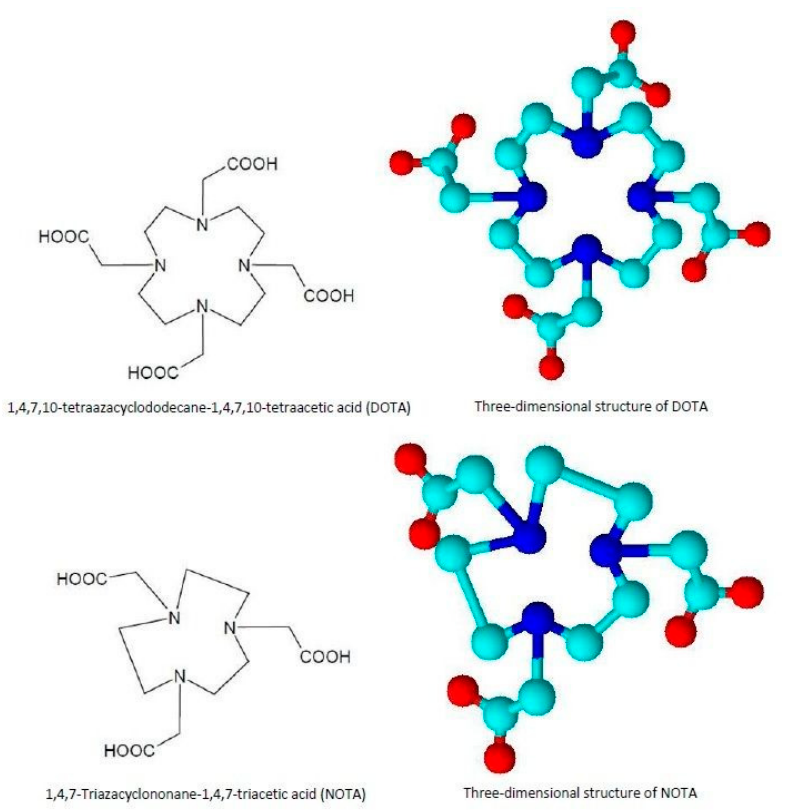
Figure 3. DOTA and NOTA chelators: chemical and three-dimensional structures. 1,4,7- triazacyclononane-N,N’,N’’-triacetic acid (NOTA) and 1,4,7,10-Tetraazacyclododecane-1,4,7,10- tetraacetic acid (DOTA).